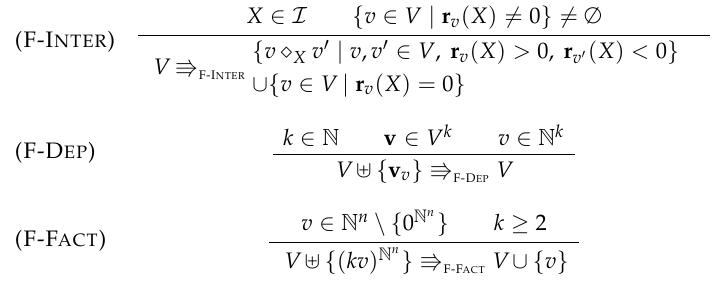
Figure 9. Simplifying flux networks for an initial n -tuple of reactions r and a set of intermediate species I